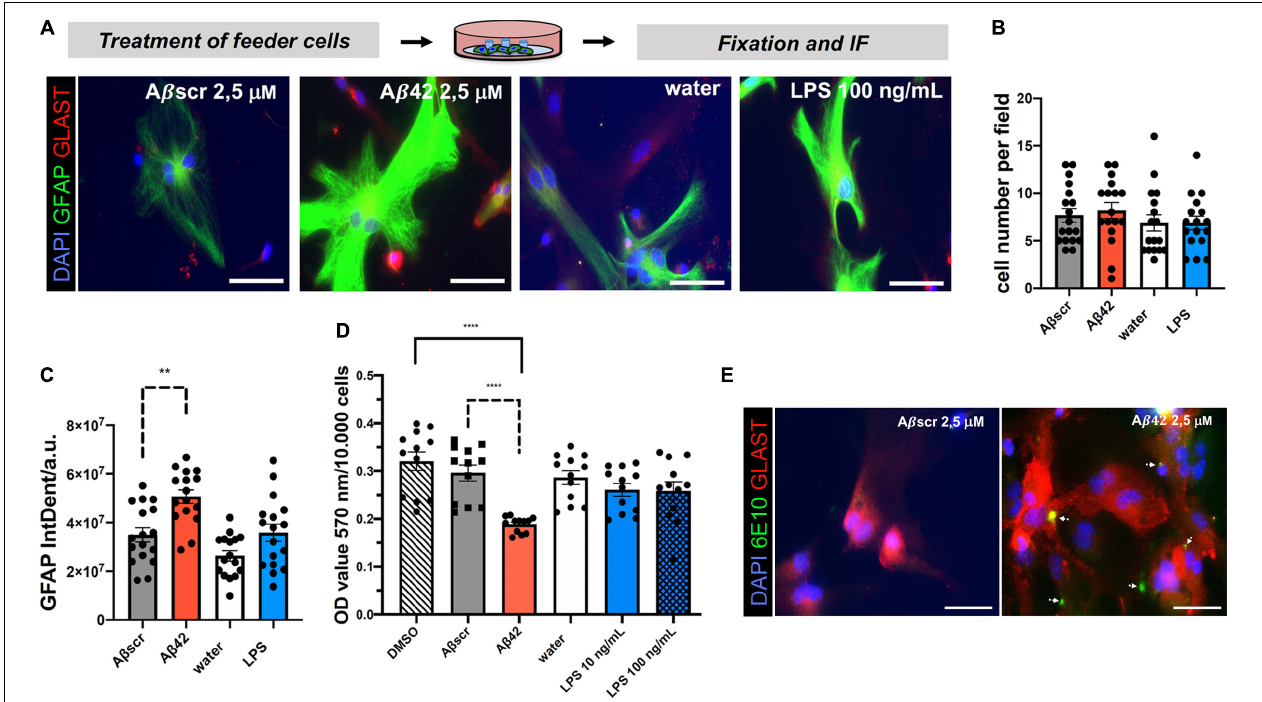
FIGURE 5 | Pre-treatment of primary astrocyte feeder cells with A β 42 or lipopolysaccharide (LPS) induces signs of reactive changes in primary astrocytes. Treatment of monocultures of primary astrocytes with different inflammatory conditions induced a reactive astrocyte characteristic. (A) Representative immunofluorescence staining with the astrocyte markers GFAP and GLAST show reactive phenotypes under both treatment conditions A β 42 or LPS in contrast to the respective controls, scale bar = 50 µ m. Evaluation of DAPI+GFAP+ cells per field of coverslips shows no changes in cell number (B) , but a significant impact of treatment with A β 42 on GFAP immunofluorescence signal intensity (IntDen) (C) and signal strength by a common MTT assay (D) . Absolute OD values for the different treatment and control groups are displayed (D). N = 3 independent experiments were performed per condition with two coverslips per experiment per treatment group (i.e., technical replicates). At least 16–18 fields with astrocytes per experimental condition were analyzed. (E) Astrocytes in monocultures were treated for 24 h with either A β 42 or A β scr at concentrations of 2.5 µ M. Astrocytes were stained against astrocytic Glast and with an A β 42-specific antibody (6E10). White arrows point at A β 42 positive staining showing binding and/or uptake of A β 42 by astrocytes in the feeder layer. Images were taken with a fluorescence microscope (Axiovert 200 (Carl Zeiss, Göttingen, Germany), scale bar = 50 µ